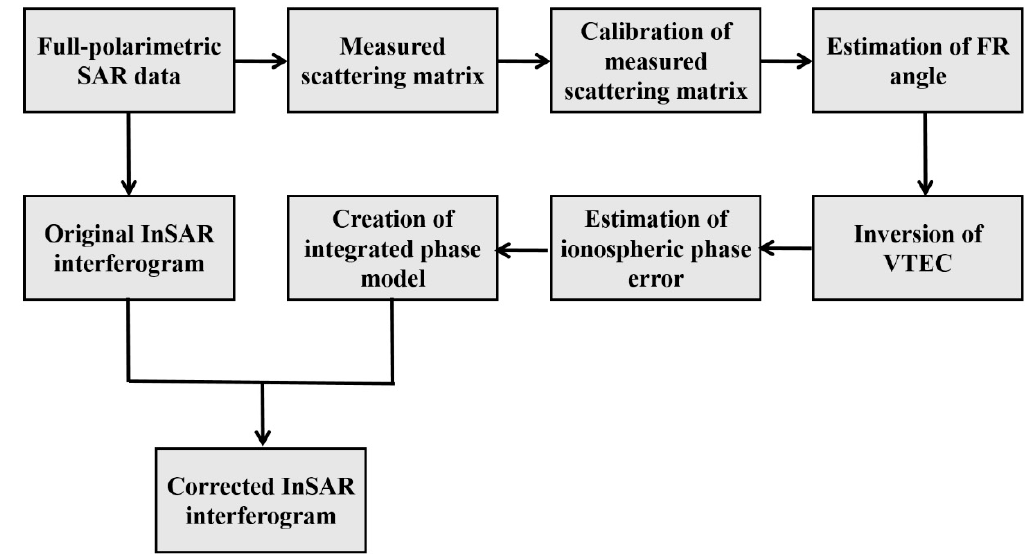
Figure 1. The flowchart of the proposed method. Synthetic aperture radar (SAR), SAR interferometry (InSAR), Faraday rotation (FR), vertical total electronic content (VTEC).